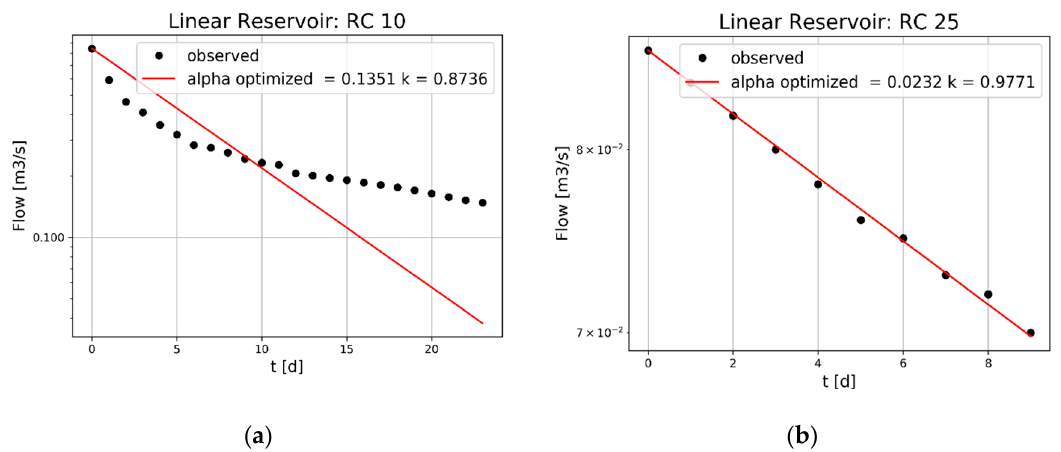
Figure 2. Semilogarithmic plot of two typical recession curve shapes; ( a ) convex; ( b ) linear.